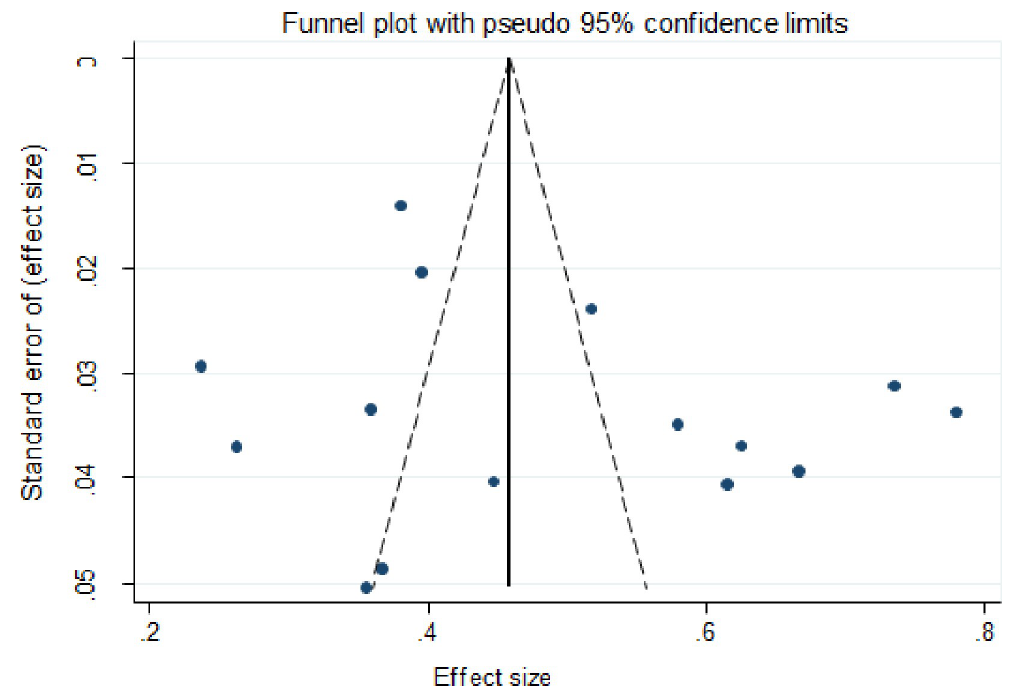
Fig 7. Funnel plot of a subgroup of 15 of the 20 selected studies for culture-positive EPTB.